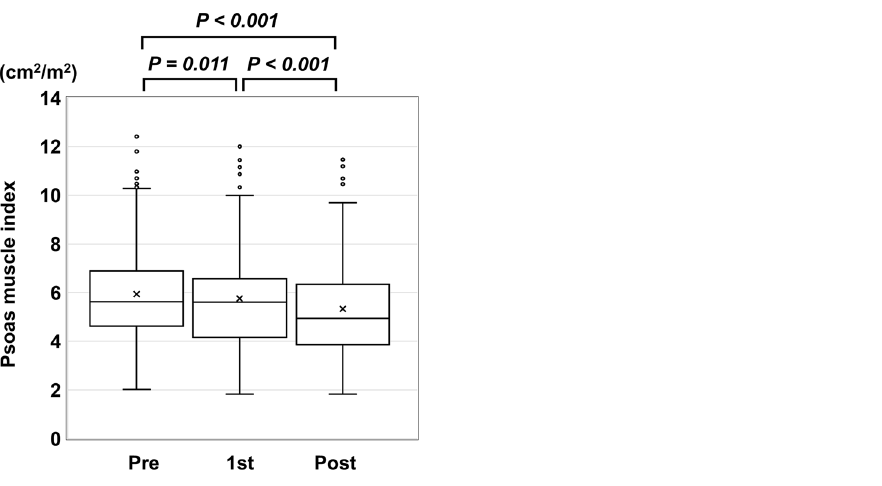
Figure 1. Transition of change in psoas muscle index (PMI) before (pre), during (1st), and after (post) administration of lenvatinib. There was a significant decrease in PMI at each successive measurement during the study